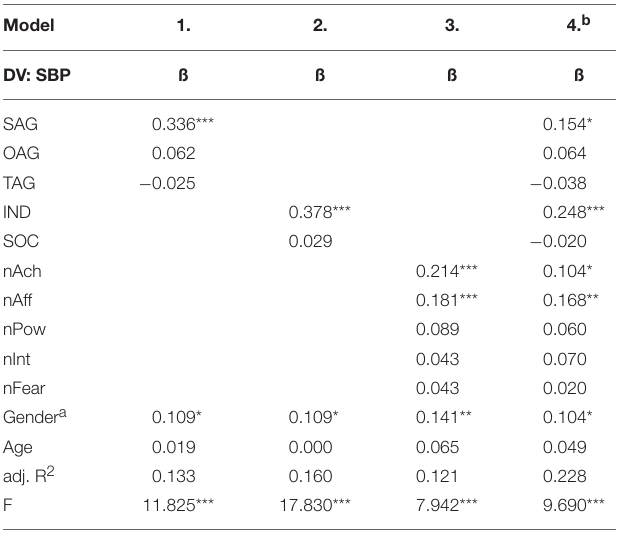
TABLE 2 | Relation of self, other, and task-approach goals, individual and social achievement values, and explicit achievement, affiliation, power, intimacy, and fear motives with self-based pride.